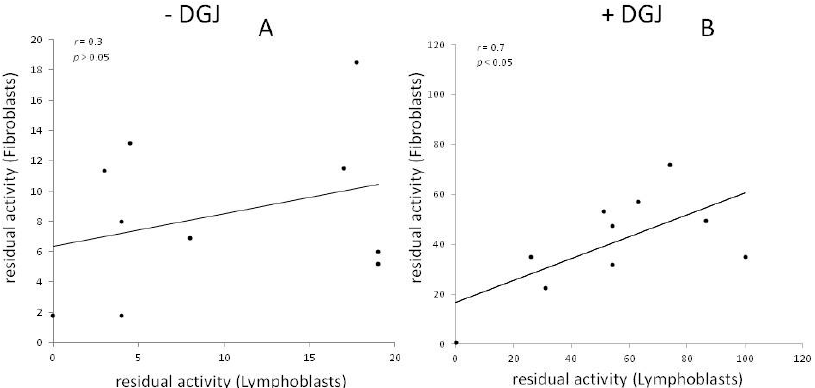
Figure 2. The residual activity of mutants measured in fibroblasts and lymphoblasts derived from patients is shown. In case that multiple reports are available for a given mutant and a given cell type, the average value was plotted. Results in the absence of DGJ ( A ) or in the presence of DGJ ( B ) are reported.